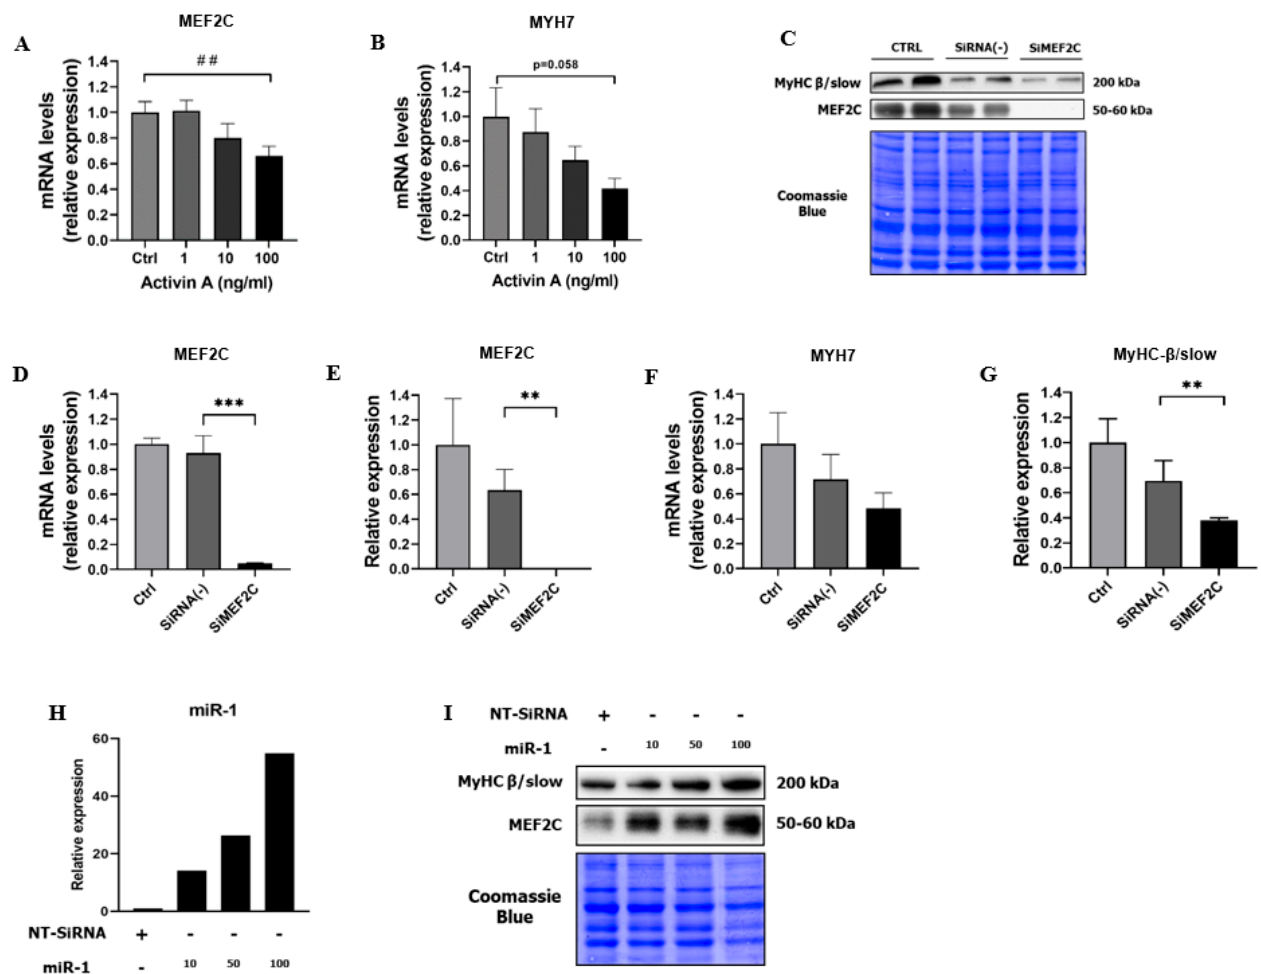
Figure 4. MEF2C is required to maintain MyHC- β /slow gene expression and protein content in differentiated myotubes. ( A , B ) MEF2C and MYH7 mRNA levels measured by RT-qPCR 48 h after exposure to increasing the dose of recombinant ActA or vehicle. ( C , E , G ) MEF2C and myosin-heavy chain- β /slow content measured by western blot and ( D – F ) MEF2C and MYH7 mRNA levels measured by RT-qPCR, 72 h after transfection of myotubes with a siRNA against MEF2C (SiMEF2C) or a negative control (non-targeting siRNA (SiRNA( − )). ( H ) MiR-1 expression measured by RT-qPCR and ( I ) MEF2C and myosin-heavy chain- β /slow content measured by western blot in myotubes, 48 h after transfection with miR-1 mimic (miR-1) in increasing concentrations (10,50,100 nM) or negative control (non-targeting SiRNA (NT-SiRNA)). Data are reported as means ± SEM (n = 3/condition), for miR-1 experiment (n = 1/condition). ## p < 0.01, ** p < 0.01, and *** p < 0.001 vs. SiRNA( − ).